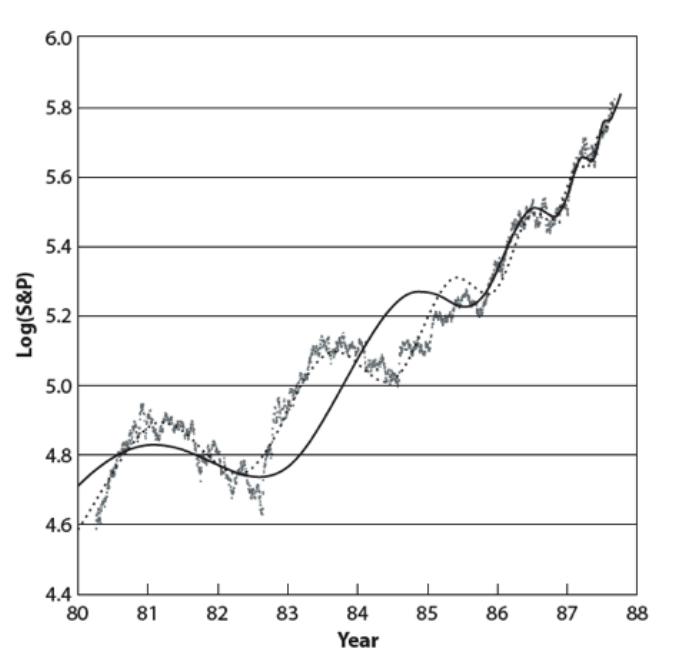
Figure 9. The historical evolution of the S&P500 index showing the price growing faster than an exponential up to its tipping point of 19th October 1987. Indeed, a “normal” exponential growth associated with a constant rate of return would be qualified by a straight line in this linear-logarithmic graph. The dotted and solid smooth black lines are the results of our model calculations with two different levels of nonlinearity. Reproduced from the book “Why stock markets crash” by D. Sornette